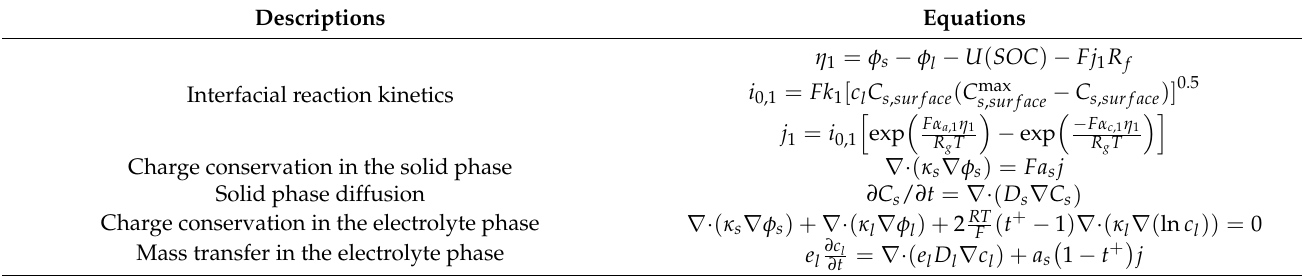
Table 2. Equations of the P2D model of a LIB.